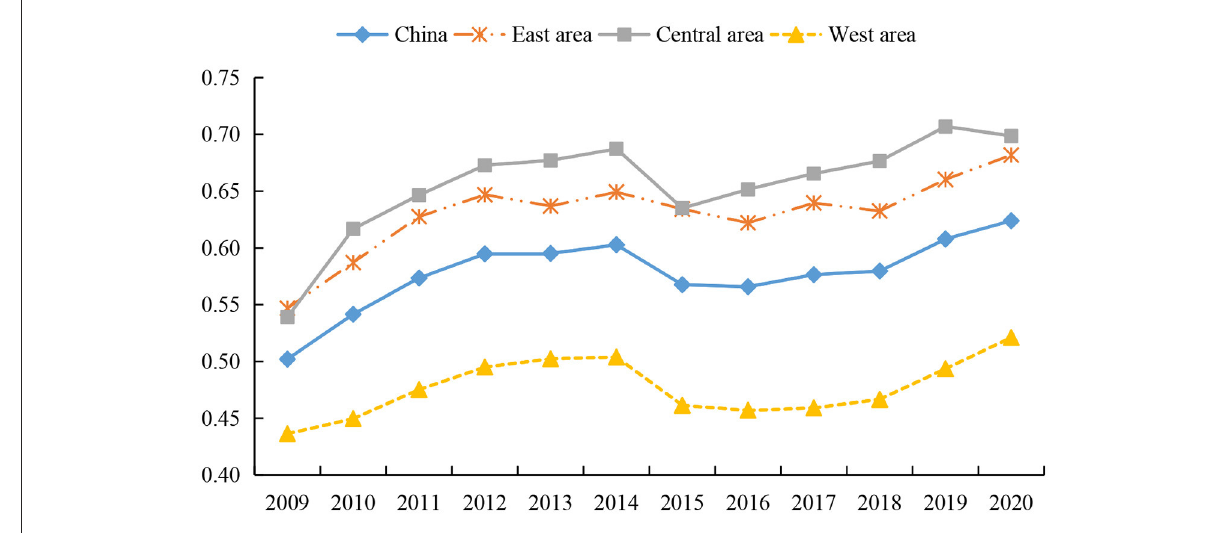
FIGURE2 Trends of overall health system efficiency in different regions from 2009 to